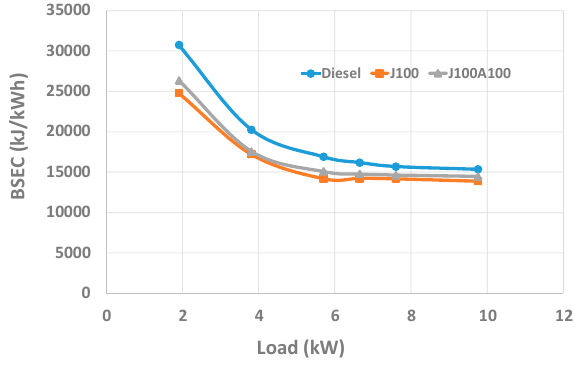
Figure 4. BSEC vs. engine load.